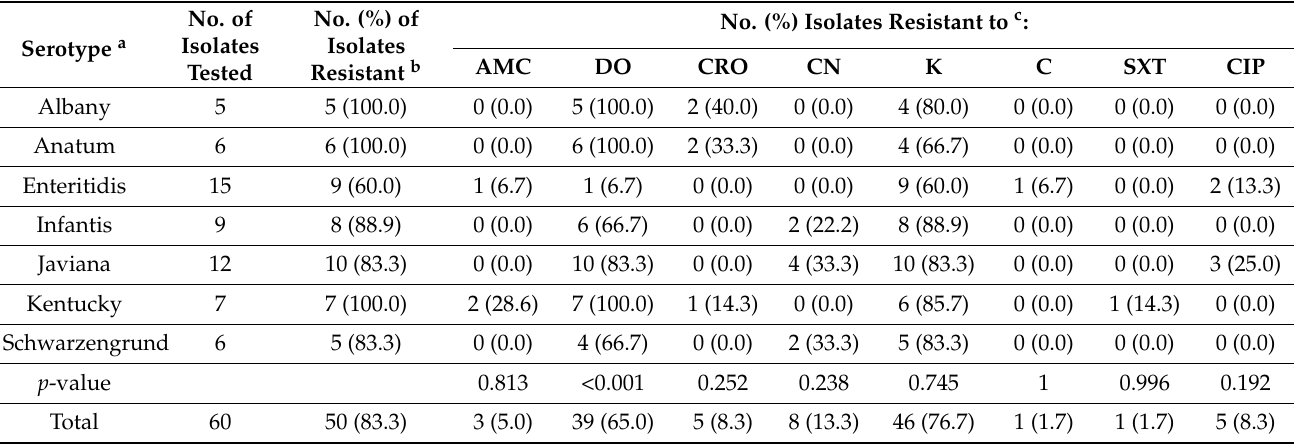
Table 7. Resistance exhibited by different serotypes isolated at four processing